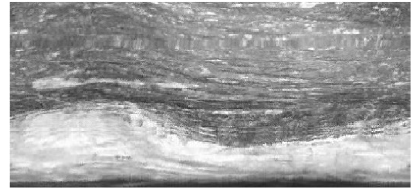
Figure 10. Panoramic view of drilling holes.